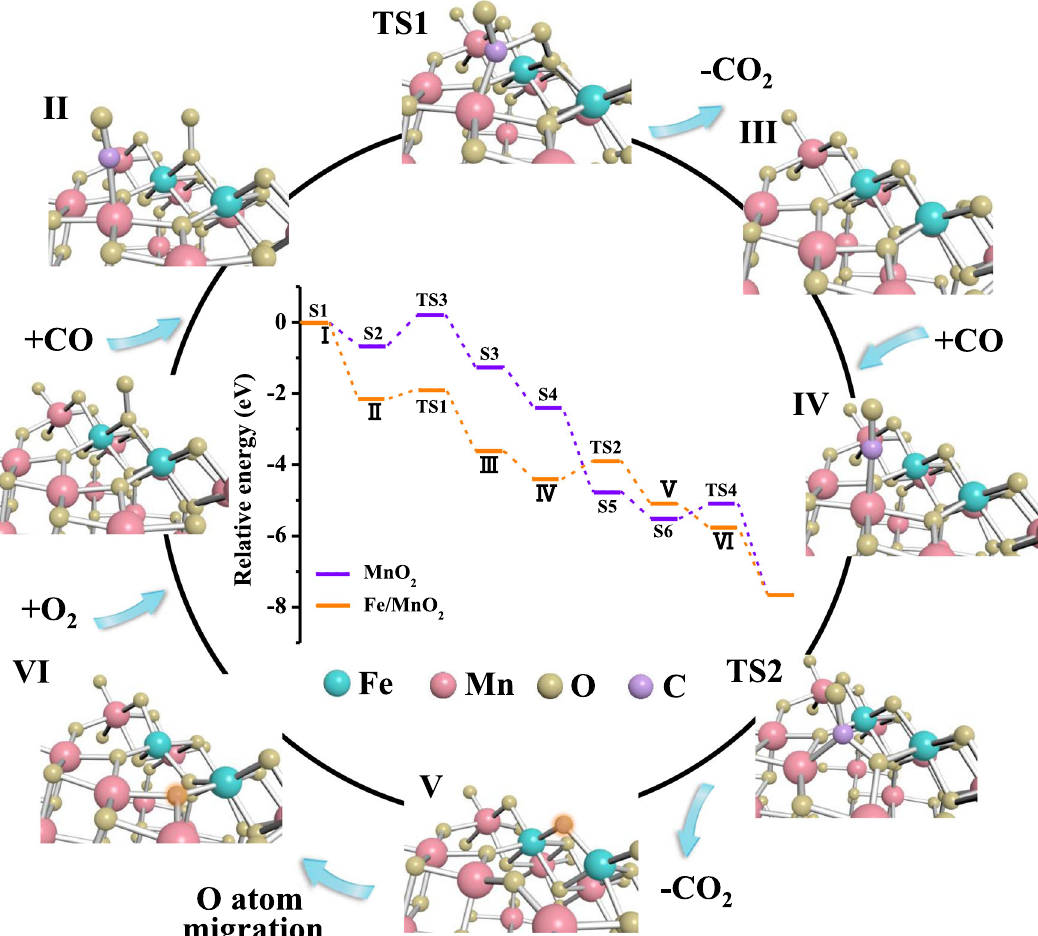
Fig. 5 Mechanistic investigations. Proposed reaction mechanism for CO oxidation on Fe/MnO 2 surface. The inset shows the calculated energy pro fi les in eV. The structures of intermediates and transition states are shown in the reaction cycle. The energy pro fi le of the reaction cycle for Fe/MnO 2 is shown by the orange line in the inset. The purple line shows the energy pro fi le for MnO 2 (reaction cycle is shown in Supplementary Fig.